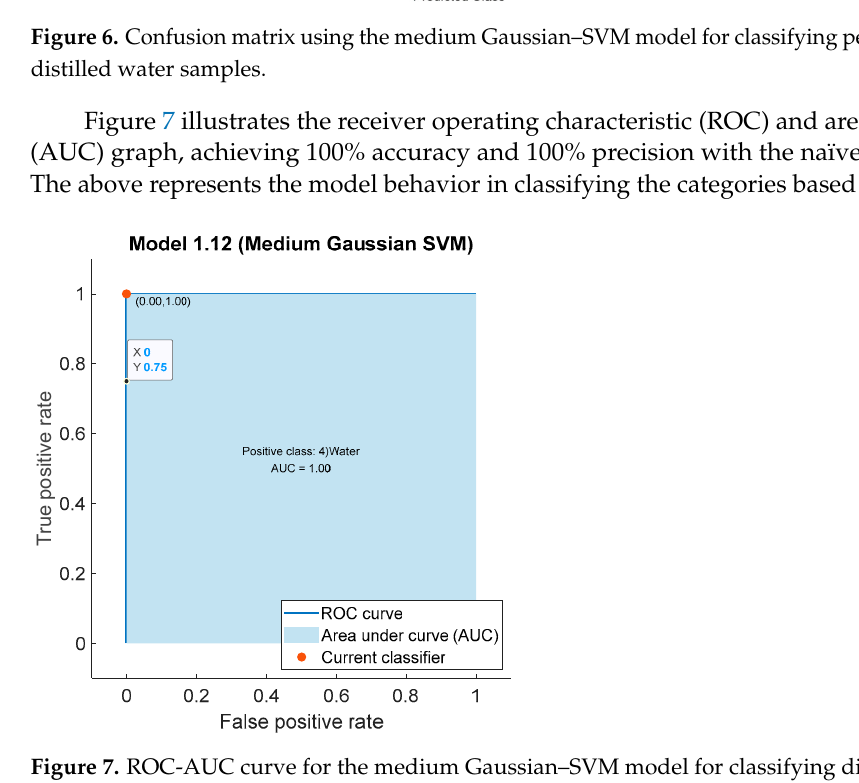
Figure 6. Confusion matrix using the medium Gaussian–SVM model for classifying pesticides against distilled water samples.